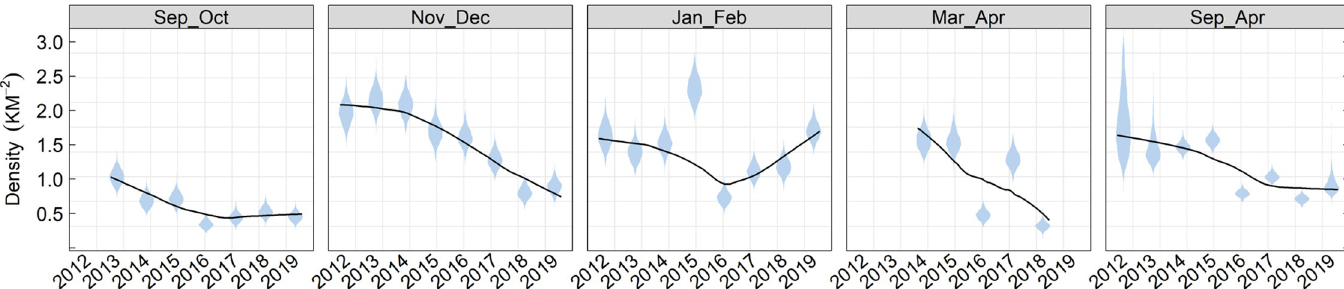
Fig 3. Marbled murrelet group size. Posterior median (points), 25–75% quartile (thick bars) and 95% credible interval (thin bars) of marbled murrelet group size by 2-month survey window for all years pooled. The dark boxplots with circles and the light plots with diamonds were derived from the non-breeding (Sep-Apr) model and year-round (Sep-Jul) model, respectively. The year-round model only includes the sampling units consistent between breeding and non-breeding seasons (n = 11) and the non-breeding model includes all 32 sampling units. For the most part, murrelets were detected as pairs or singles. As a result, we did not attempt to model the effect of group size on detection by